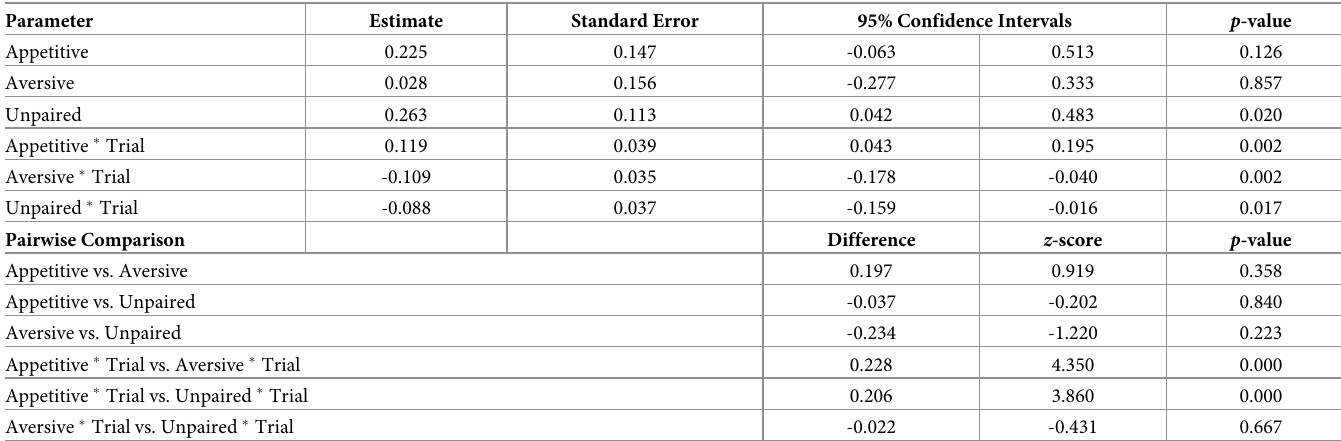
Table 2. Experiment 1 conditioning CS approach